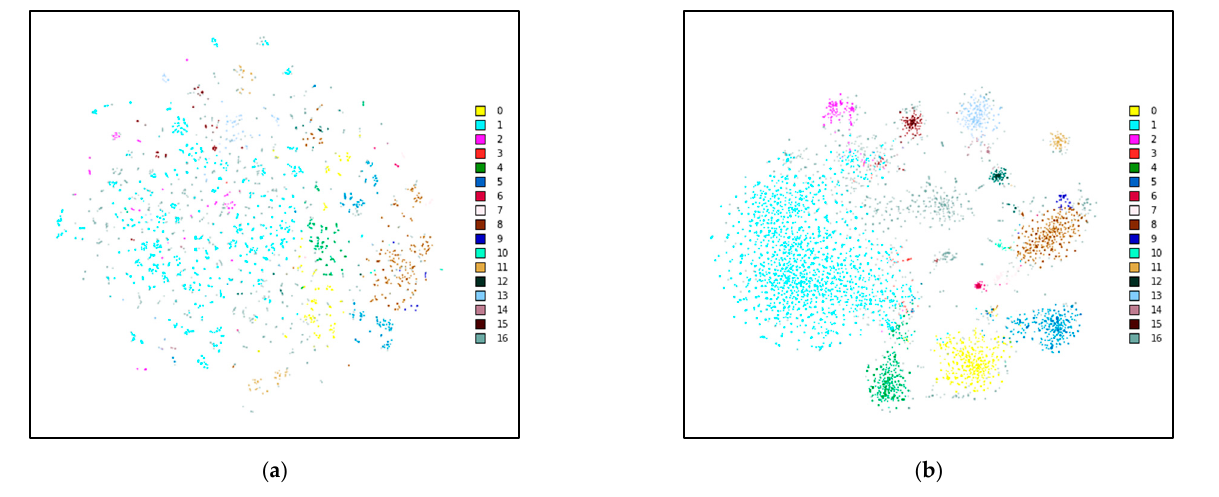
Figure 11. t-SNE visualization of the object proposal embeddings of the baseline without and with RIC loss. ( a ) Proposal embeddings of the baseline. ( b ) Proposal embeddings of the baseline with RIC